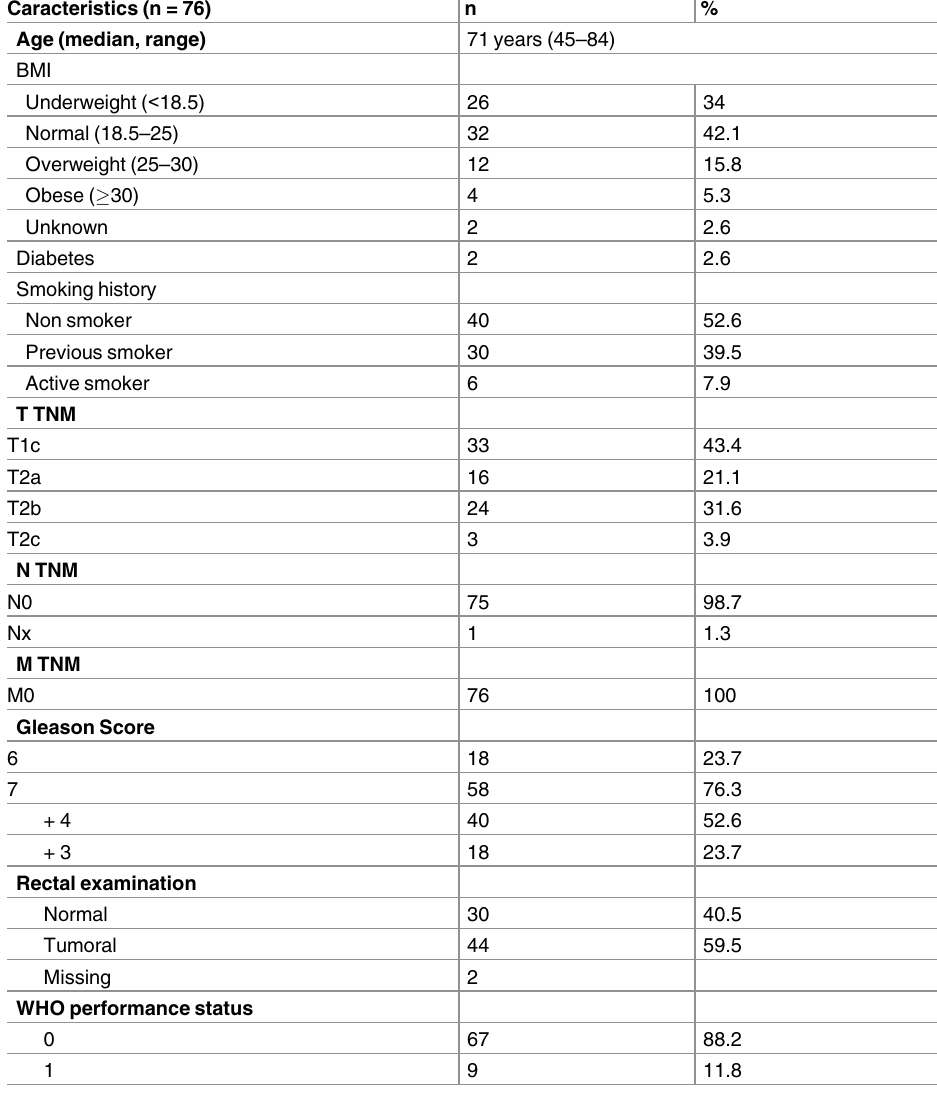
Table 1. Demographic, clinical and pathological characteristics of patients at baseline.